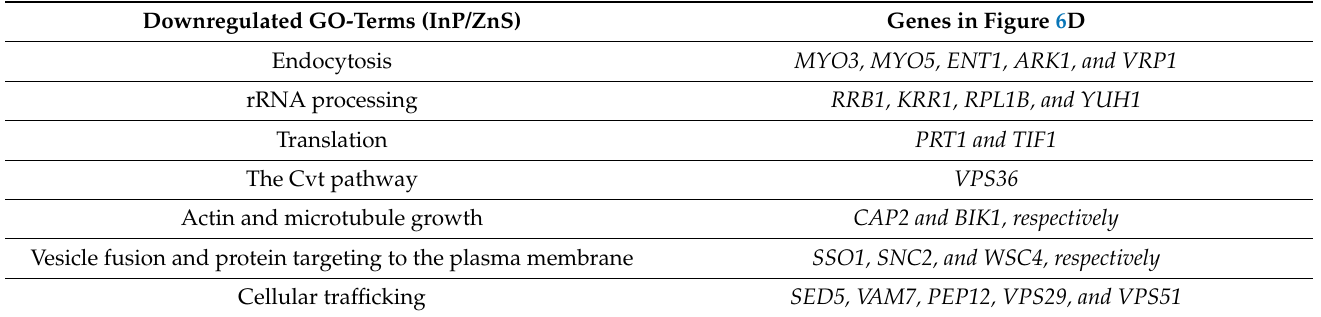
Table 6. A table listing the GO-terms and genes in Figure 6D. It represents the multiple downregulated cellular processes and genes in yeast exposed to 100 µ g/mL InP/ZnS QDs. All genes incorporated in this table exhibited expression levels significantly lower than expression levels of NTC